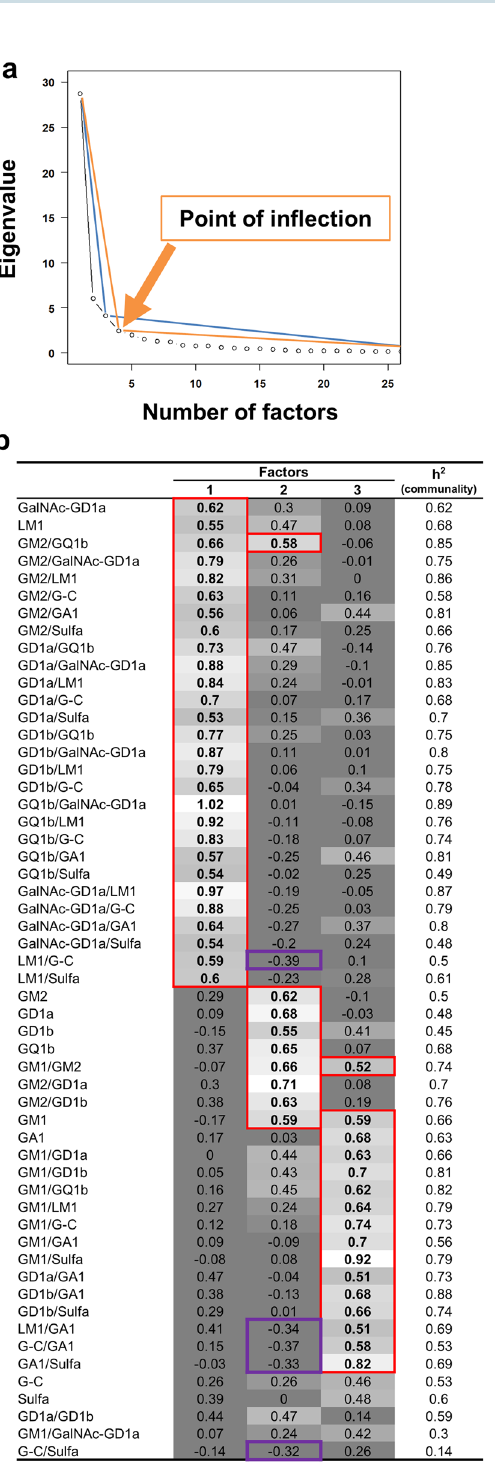
Figure 7. EFA of IgM glycoarray data from GBS patients. ( a ) The point of inflection of the scree plot with the eigenvalues and number of factors indicated that three or four factors were the adequate number of common factors. ( b ) Factor loadings greater than 0.5 (shown in red boxes) or less than –0.3 (shown in purple boxes) were selected as related variables forming the particular factors. We identified three common factors: Factor 1 had high factor loadings in GalNAc-GD1a, LM1, and glycolipid complexes, including GalNAc-GD1a, LM1, G-C, GA1, Sulfa, and GQ1b. Factor 2 had high factor loadings in GM1, GM2, GD1a, GD1b, GQ1b, and their complexes. Factor 2 also had moderately negative factor loadings in LM1/G-C, LM1/GA1, G-C/GA1, GA1/ Sulfa, and G-C/Sulfa. Factor 3 had high factor loadings in GM1, GA1, and their complexes. A parameter, h 2 , indicates communality that is the ratio (0 to 1) of variance explained by the three